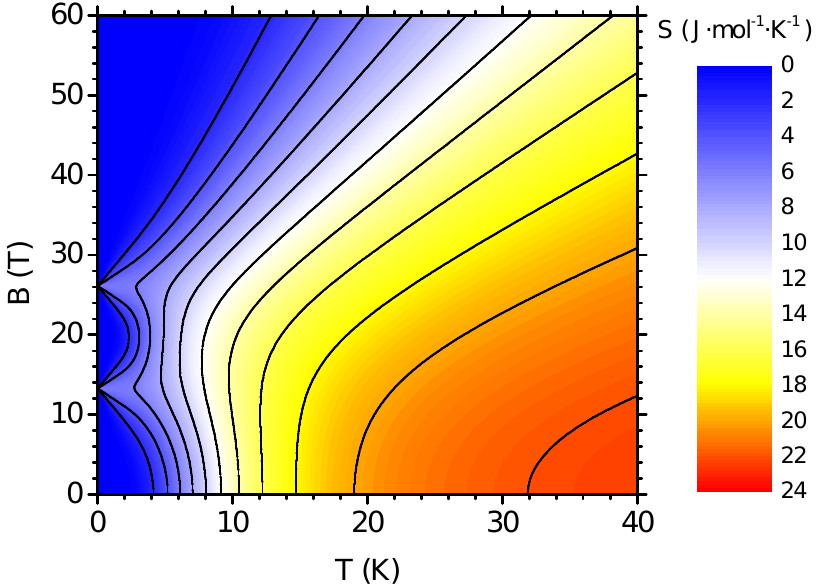
Figure 3. The density plot with contours showing the magnetic entropy per mole as a function of the temperature and the external magnetic field.